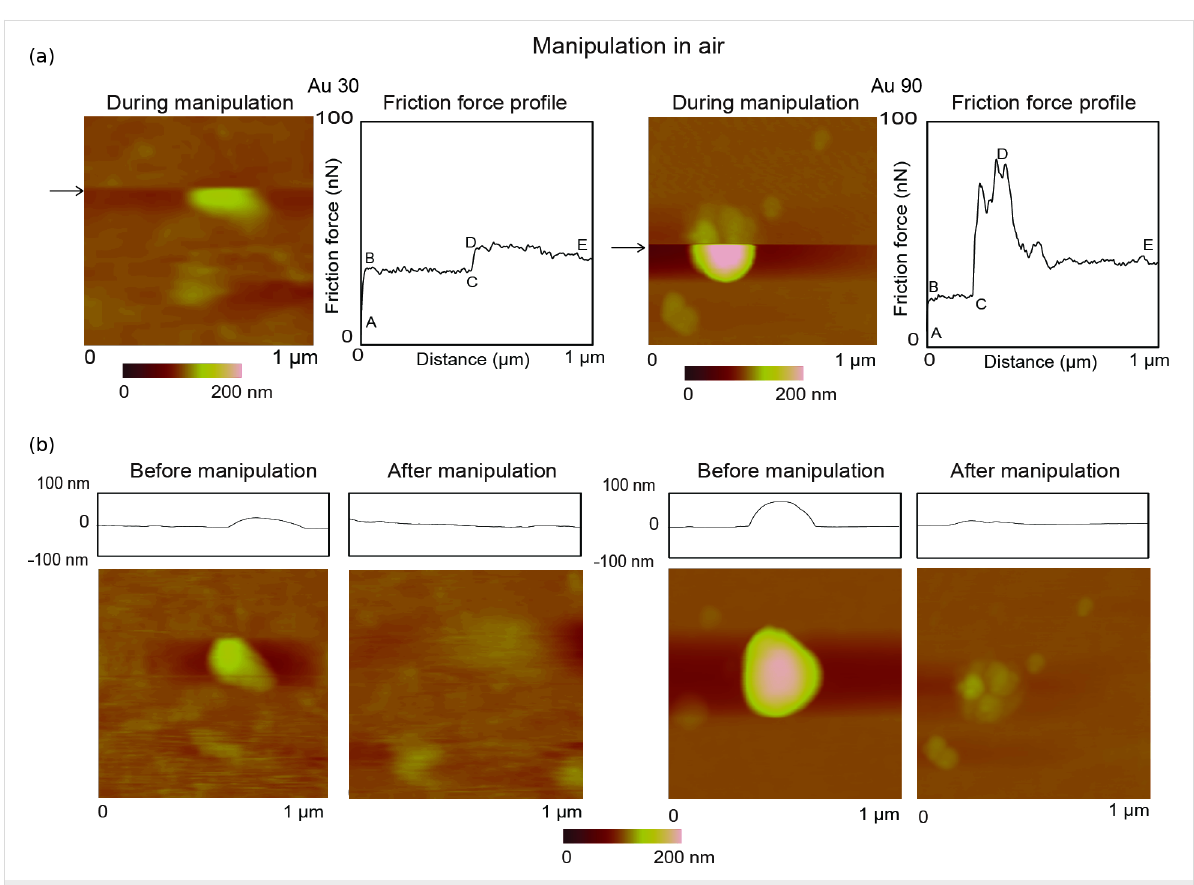
Figure 6: (a) Topography maps and 2-D friction force profiles of Au (30 nm in diameter) and Au (90 nm in diameter) during manipulation of single nanoparticles in dry conditions. During manipulation, the normal load is increased (A–B) at the approximate center of the particle image (indicated by the black arrows) from 10 nN to 300 nN on a single scan line. On this scan line, the sharp tip slides laterally (B–C) until contact is made with the particle. The lateral friction force (C–D) increases, as the sharp tip pushes against the particle, until it begins to slide. E shows the end of the scan line. (b) Two examples of topography images and height profiles showing the same scan area before and after